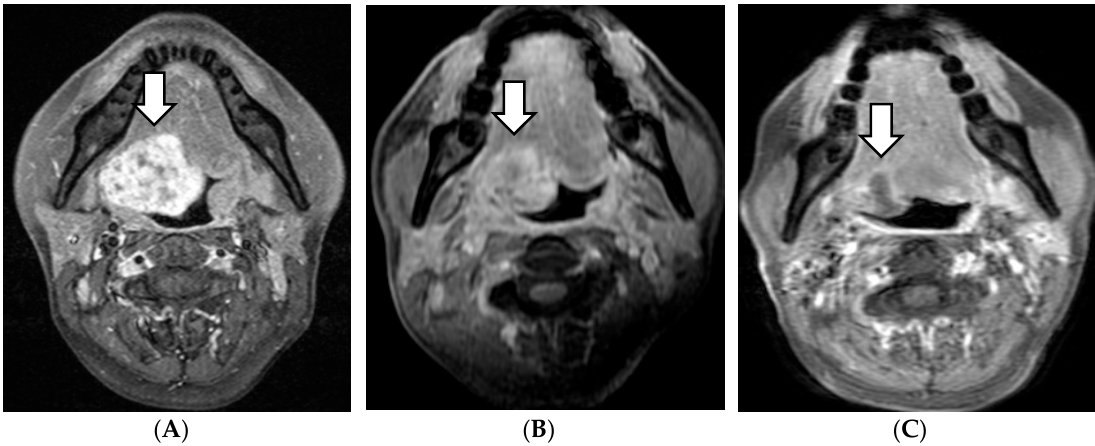
Figure 1. MRI of a patient, cT3N1MO case. The initial treatment effect was PR; thereafter, the tumor continued to shrink. ( A ) Before treatment. ( B ) After 3 months. ( C ) After 48 months. White arrow: initial or remaining tumor.